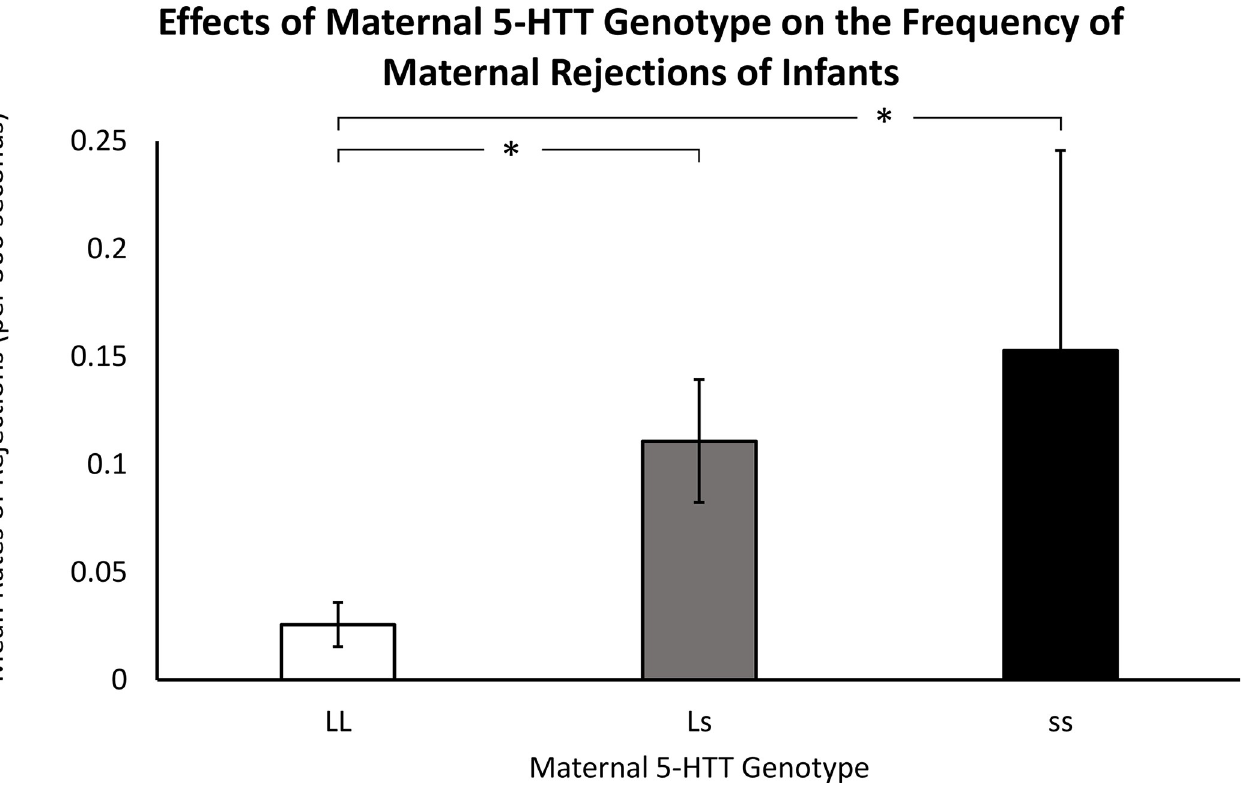
Fig 1. Effects of maternal 5-HTT genotype on the frequency of maternal rejections of infants. When compared to mothers that were homozygous for the L allele, mothers that were homozygous for the s allele exhibited higher rates of infant rejections ( p = .03). Mothers that were homozygous for the L allele also exhibited fewer rejections, when compared to mothers that were heterozygous ( p = .03). White bars indicate mothers that were homozygous for the L allele, gray bars indicate heterozygous mothers, and black bars indicate mothers that were homozygous for the s allele. Error bars are standard errors.